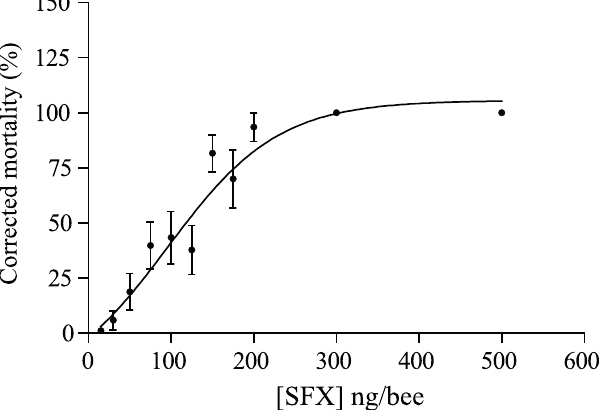
Fig 2. In vivo oral toxicity of sulfoxaflor to the honeybees, Apis mellifera . Toxicity curve of sulfoxaflor for adult forager honeybees. 30 bees were placed into each cage and 300 μ l of the test solutions (10 μ l.bee -1 ) were provided inside the cage using an eppendorf cap. SFX doses ranging from 15 ng to 500 ng/bee were tested. Mortality rate was assessed 48 h after intoxication. Each value is the mean ± SEM of three independent